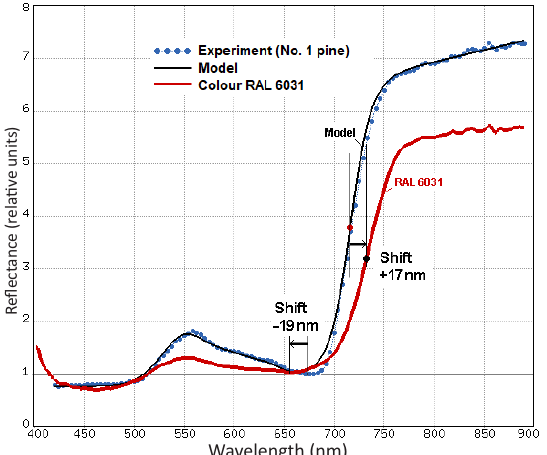
Fig. 9. Comparison of the reflectance spectrum of a standard masking colour RAL 6031 with an experimental pine forest spectrum and the compact GVR model with four amplitude parameters fitted for the actual pine forest. While the model simulates with a nearly excellent accuracy the real forest, the critical wavelengths of the masking colour are somewhat shifted from the respective values of the real